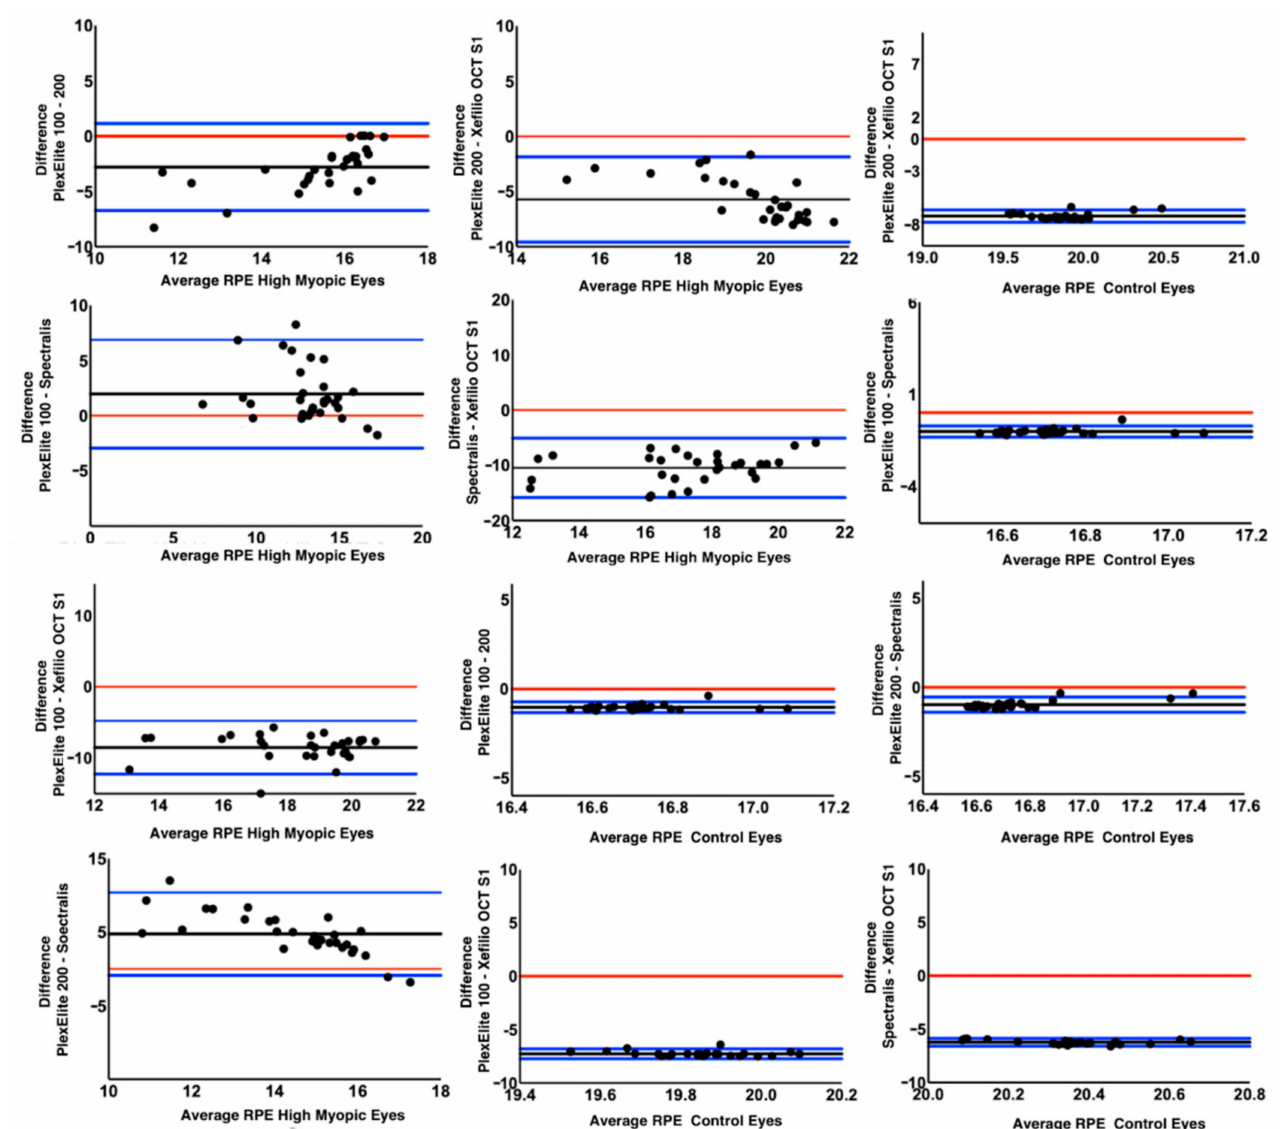
Figure 3. Bland-Altman plots comparing the amount of visible retinal pigment epithelium between the different optical coherence tomography devices for the horizontal scans in high myopia cohort and controls. The black lines indicate the mean difference between the different devices. The blue lines show the upper and lower limits of agreements. The red line denotes the zero difference between the